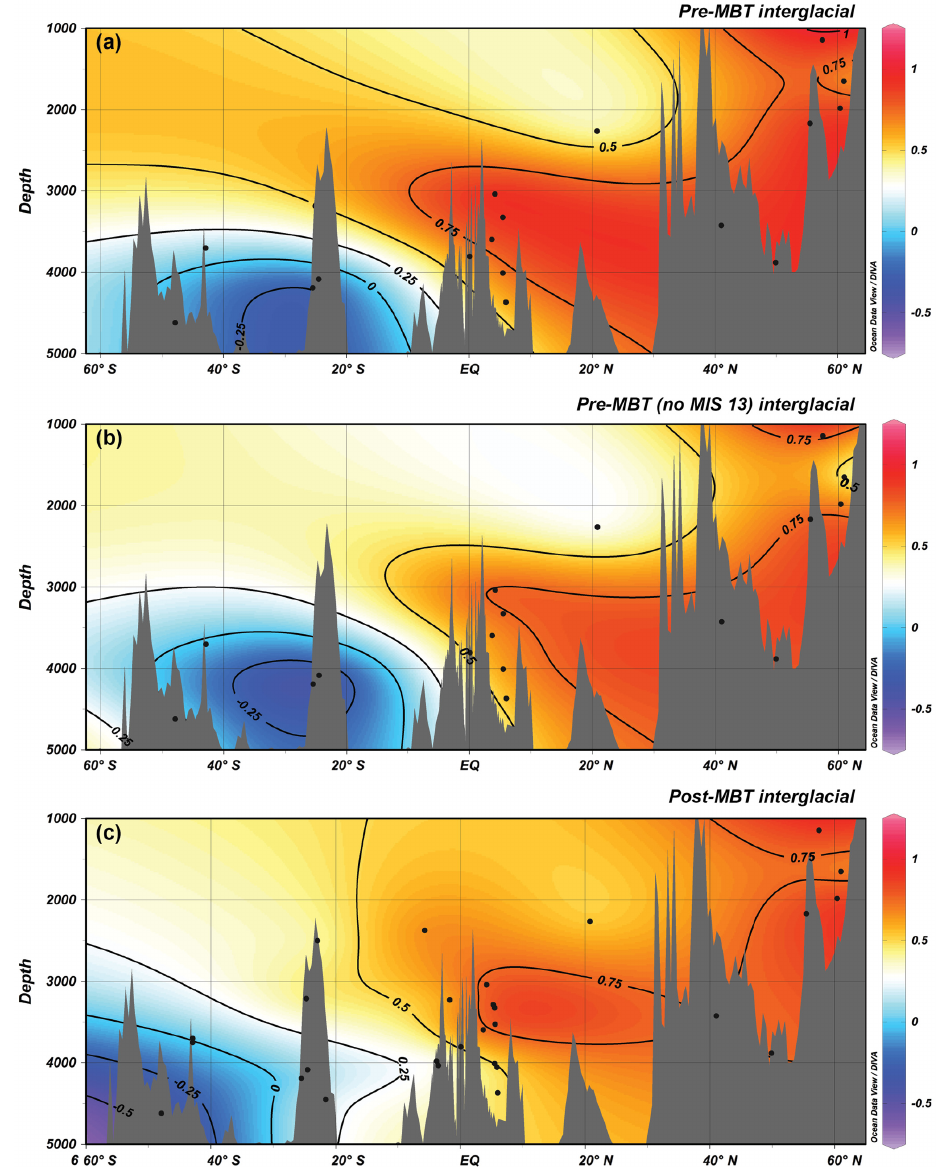
Figure 12. Average interglacial ∂ 13 C contours. Contour plots of the average interglacial ∂ 13 C values in the Atlantic for (a) pre-MBT included MIS 13, (b) pre-MBT excluding MIS 13 (enriched carbon isotope excursion), and (c) post-MBT. Red colors indicate higher ∂ 13 C values. Blue colors indicate lower ∂ 13 C values. The boundary between the two water masses (NADW and AABW) is indicated at the 0.25‰ contour (Curry and Oppo,